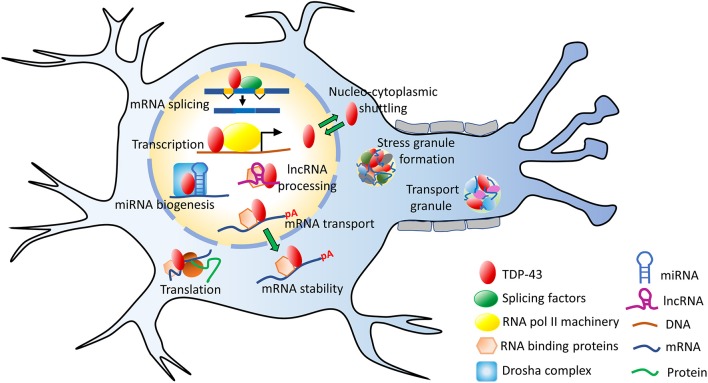
Functions of TDP-43. TDP-43 performs several mRNA-related processes in the nucleus, such as transcription, splicing, maintaining RNA stability as well as miRNA and lncRNA processing. It is predominantly a nuclear protein but also shuttles between the nucleus and the cytoplasm. In the cytoplasm, TDP-43 participates in the stress granule formation, ribonucleoprotein (RNP) transport granule formation, translation and other processes. lncRNA, long non-coding RNA; miRNA, microRNA; mRNA, messenger RNA; pA, poly-A mRNA tail; TDP-43, TAR DNA binding protein 43.